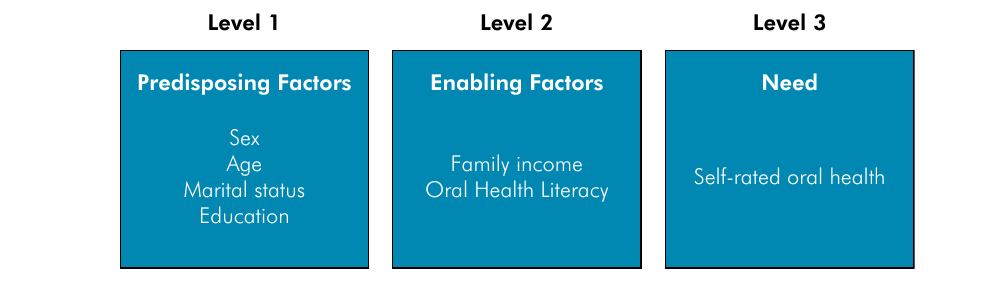
Figure. Framework employed in the analytical process (adapted from the model proposed by Andersen and Davidson,